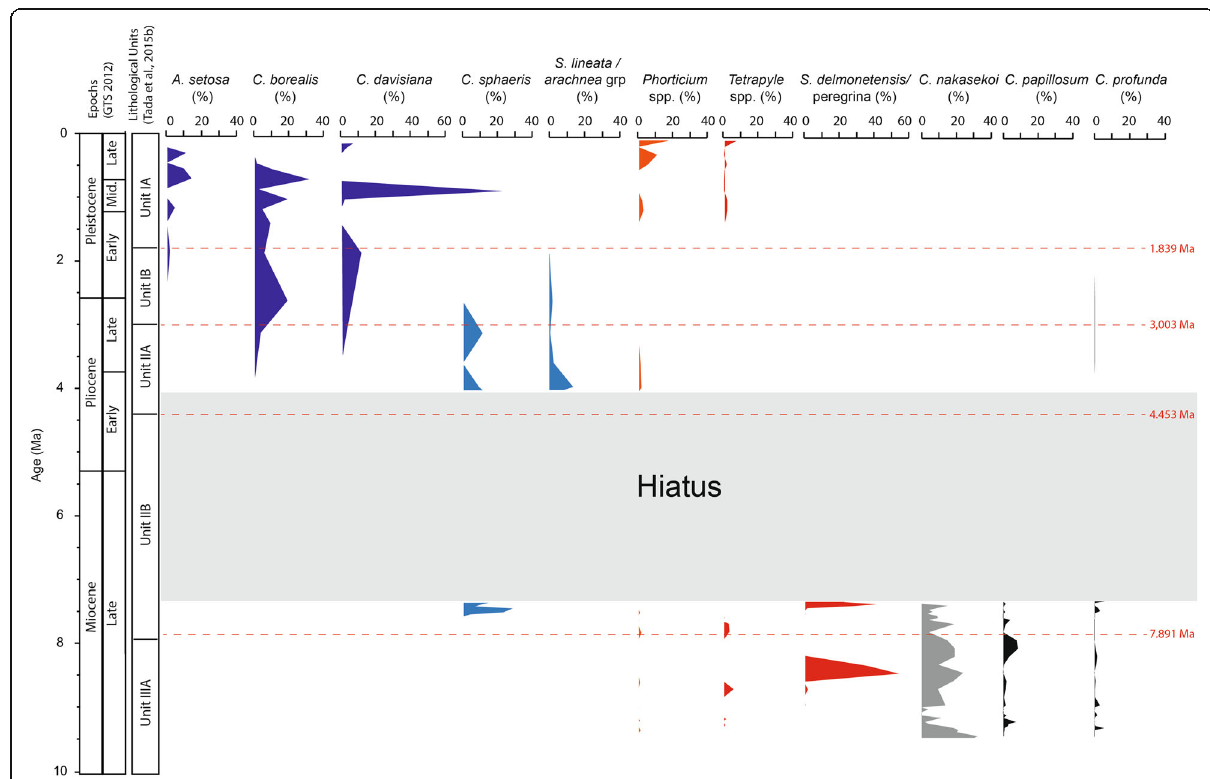
Fig. 5 Relative abundance (%) of selected radiolarian species at Site U1430 plotted by age (Ma) (Kamikuri et al. 2017 depth age model) and compared to the lithological units of Tada et al.